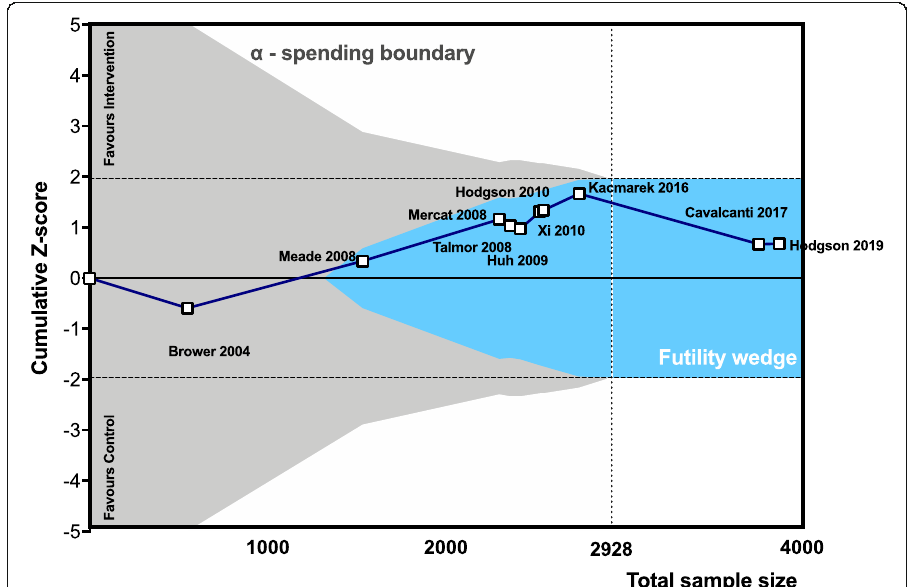
Fig. 4 Trial sequential analysis assessing the effects of PEEP and/or recruitment manoeuvres on mortality (collapsed at 28 days, ICU discharge, hospital discharge). Required information size of 2487 patients (dotted line) is calculated for a relative risk reduction of 25%, α = 5%, power (1- β ) = 80%. The Z-line (blue line) of the cumulative meta-analysis of 3757 patients did not cross the efficacy monitoring boundaries for benefit or harm (grey area) but entered the futility wedge (light blue area). Horizontal dashed lines represent the conventional level of significance ( p =